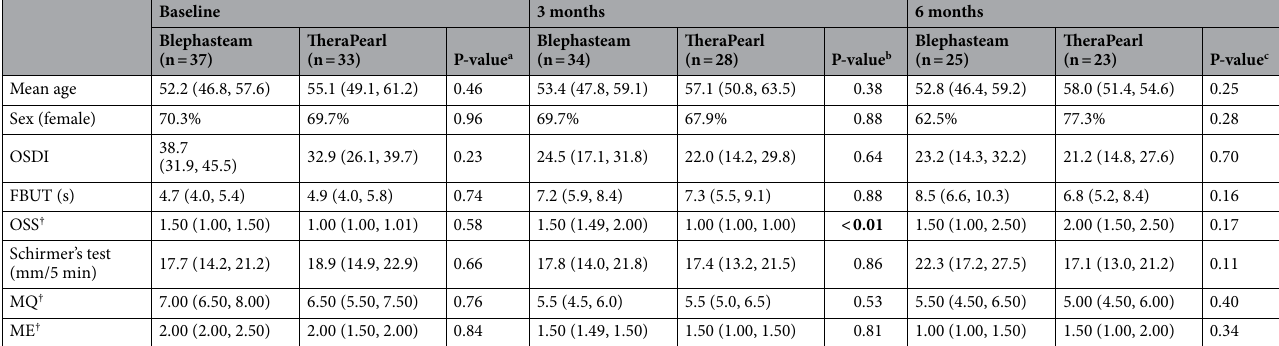
Table 2. Characteristics of study subjects at baseline, 3, and 6 month visits. Values are displayed as means with a 95% confidence interval. †Median values were reported. a p-value between the two groups at baseline. b At 3 months. c At 6 months. P-values given in bold are considered statistically significant. OSDI ocular surface disease index measured on a scale from 0 to 100, FBUT fluorescein breakup time, OSS ocular surface staining scored with the Oxford grading scheme from 0 to 15 42 , MQ meibomian quality scored on a scale from 0 to 24, ME meibomian expressibility scored on a scale from 0 to